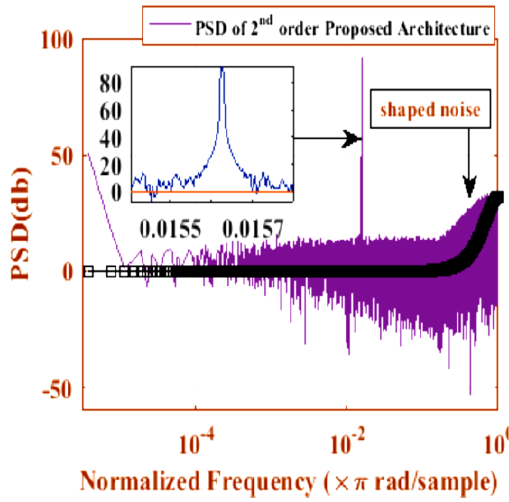
Figure 12. PSD of 3rd order hybrid MASH-EFM.